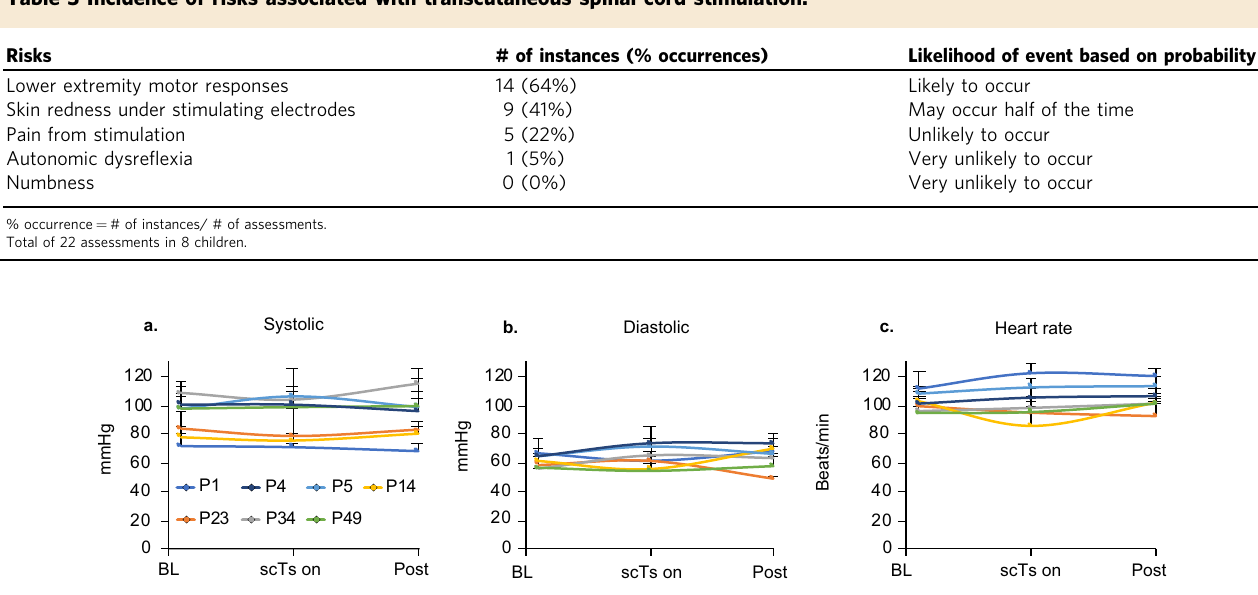
Fig. 1 Hemodynamic parameters in response to acute transcutaneous spinal cord stimulation (scTs) in children with spinal cord injury (SCI). Systolic ( a ) and diastolic ( b ) blood pressure (millimeter of Mercury, mmHg) and heart rate ( c ) (beats/minute) measurements during experiments at baseline (BL, 1